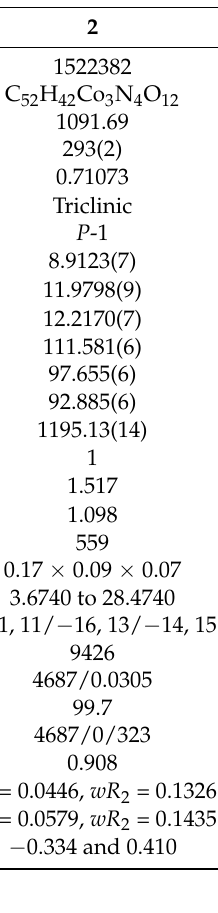
Table 1. Crystal data and structure refinement for complexes 1 and 2